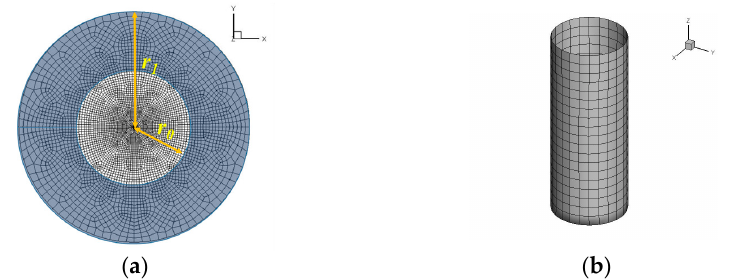
Figure 4. ( a ) Mesh on the free surface of the simulation domain and ( b ) mesh on the surface of the monopile body.